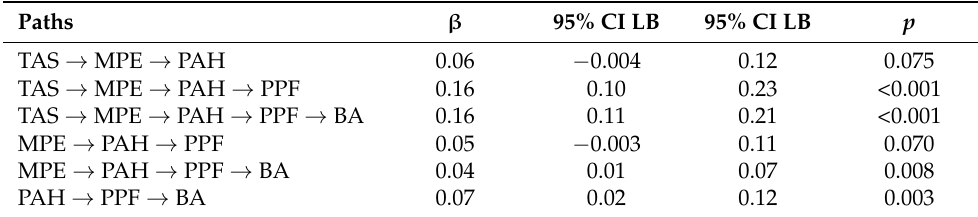
Table 3. Standardised indirect effects in girls’ mediation model, n = 371. Paths